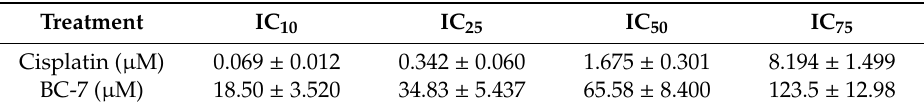
Table 1. IC 10 , IC 25 , IC 50 , and IC 75 values for 5-aminopyrazole derivative N -[[3-(4-bromophenyl)-1 H -